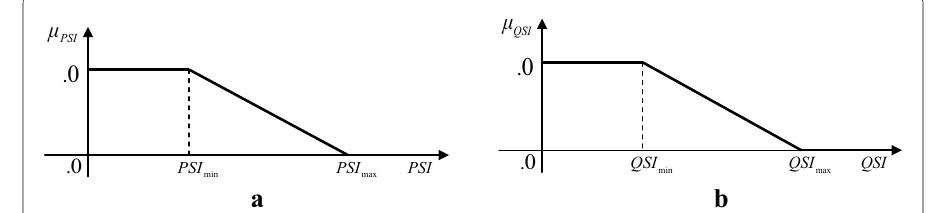
Fig. 2 a Membership function for S/S real power supply. b Membership function for S/S reactive power